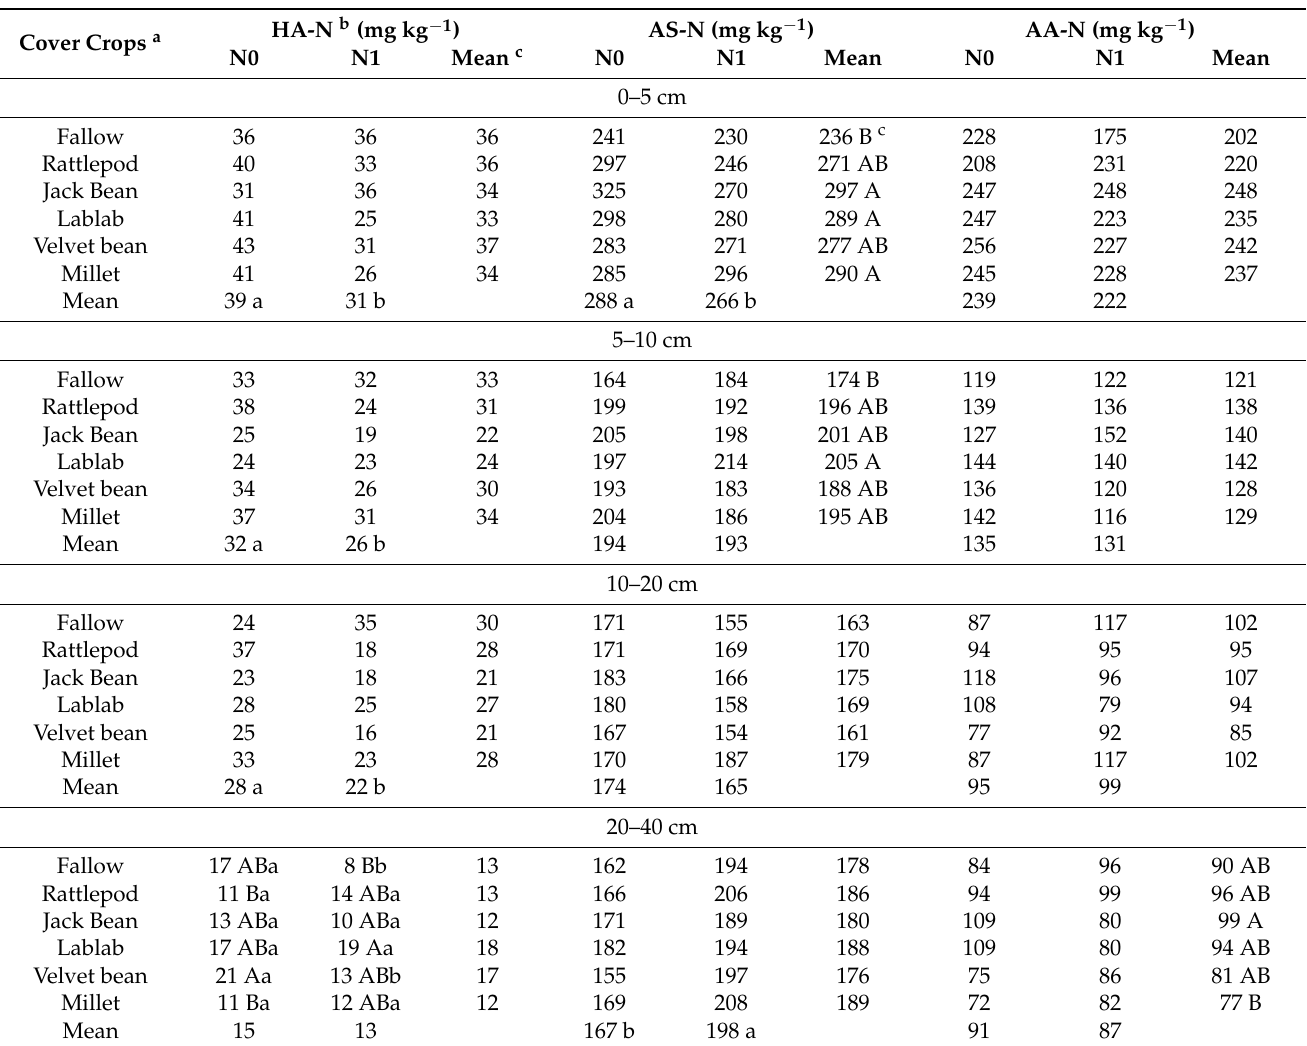
Table 5. Concentrations of soil nitrogen fractions of hydrolyzable ammonium, amino sugar, and amino acids from soil samples collected from 0–5, 5–10, 10–20, and 20–40 cm depths as a function of cover crops grown before maize and nitrogen fertilizer